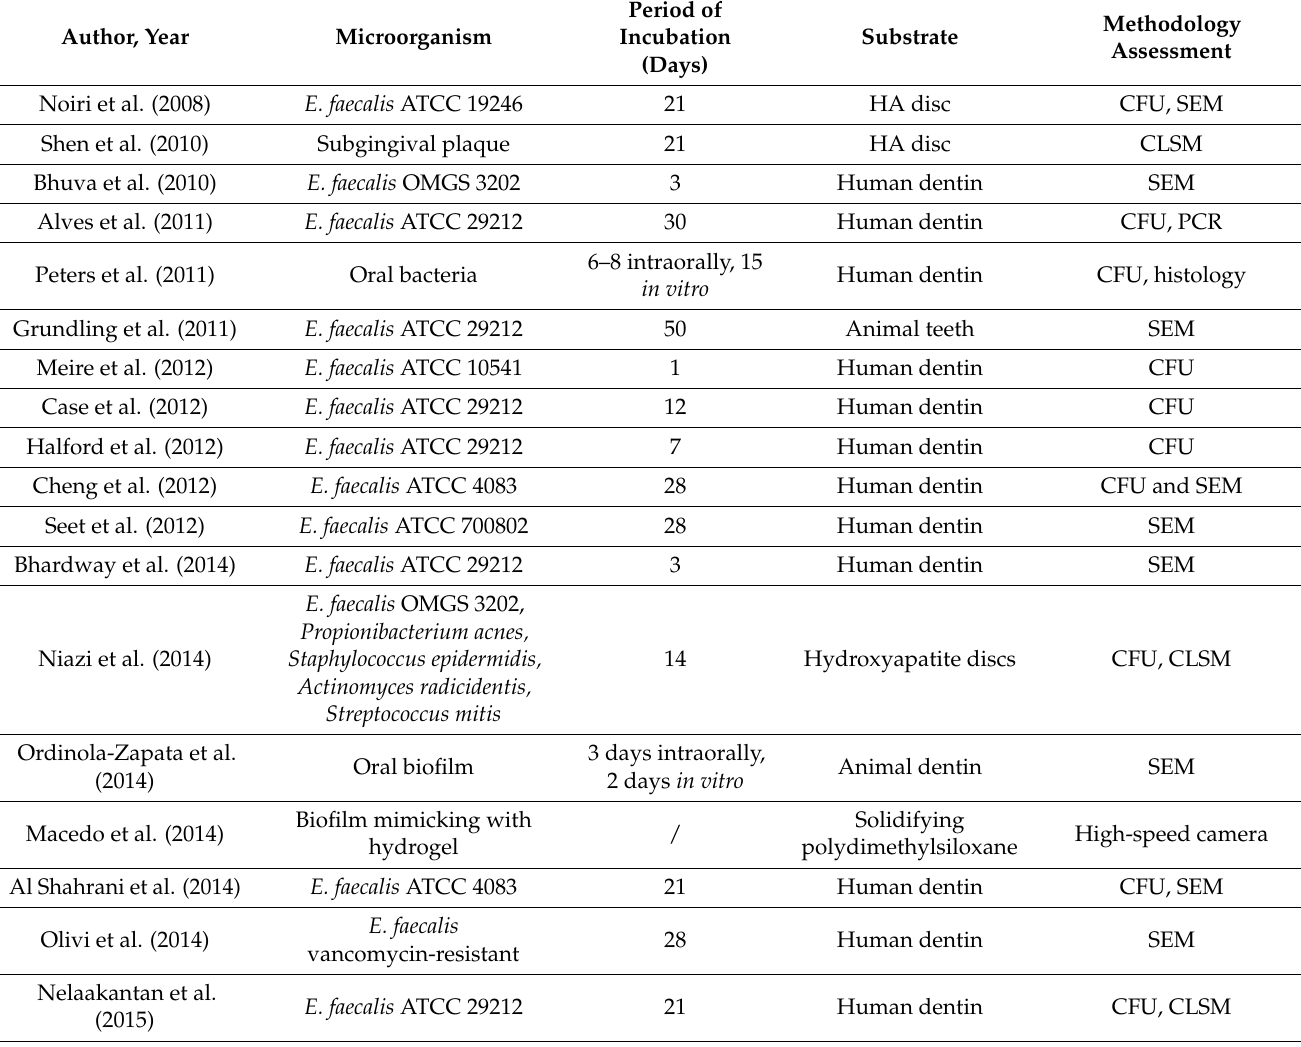
Table 1. Details of the biofilm cultivation methods and cleaning evaluation techniques of the